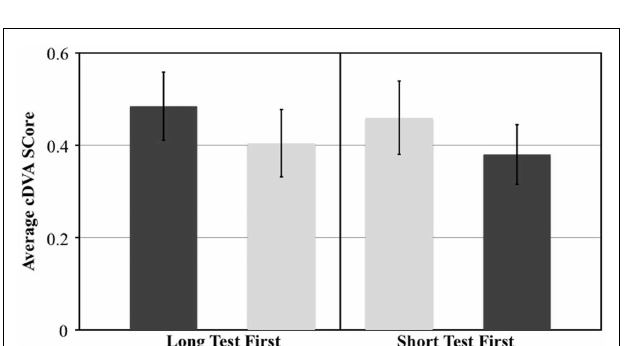
function and more extensive practice trials may be considered to better familiarize subjects before data collection in future